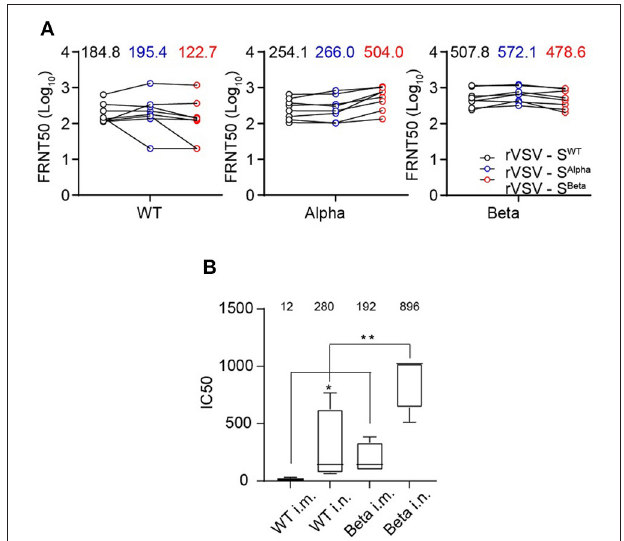
FIGURE 6 | Immunogenicity of recently emerged variants of concern, Alpha and Beta. (A) Immunogenicity of SARS-CoV-2S Alpha and Beta variants. Groups of female hACE2 knock-in ICR mice ( n = 8) were vaccinated with a single dose of rVSV-S WT or variants via i.p. route (1 × 10 6 FFU/animal). NAb titers against rVSV-S WT , Alpha, and Beta variants were determined by FRNT and calculated by the Reed-Muench method at 30 days post-vaccination. Group GMTs were indicated. All the results are representative of three independent experiments. (B) 10 5 PFU rVSV-S WT and rVSV-S Beta variant were immunized into golden Syrian hamster separately by intramuscular and intranasal injection ( n = 5). Sera were collected at 30 days post-immunization and detected for neutralizing capacity by CPE reduction against authentic WT SARS-CoV-2 (IC50). Group GMTs were marked in the graph. Statistical significance was evaluated by unpaired two-tailed student’s t test. ** p < 0.01, * p < 0.05. Error bars indicate standard deviation of the mean. All neutralization assays were performed in